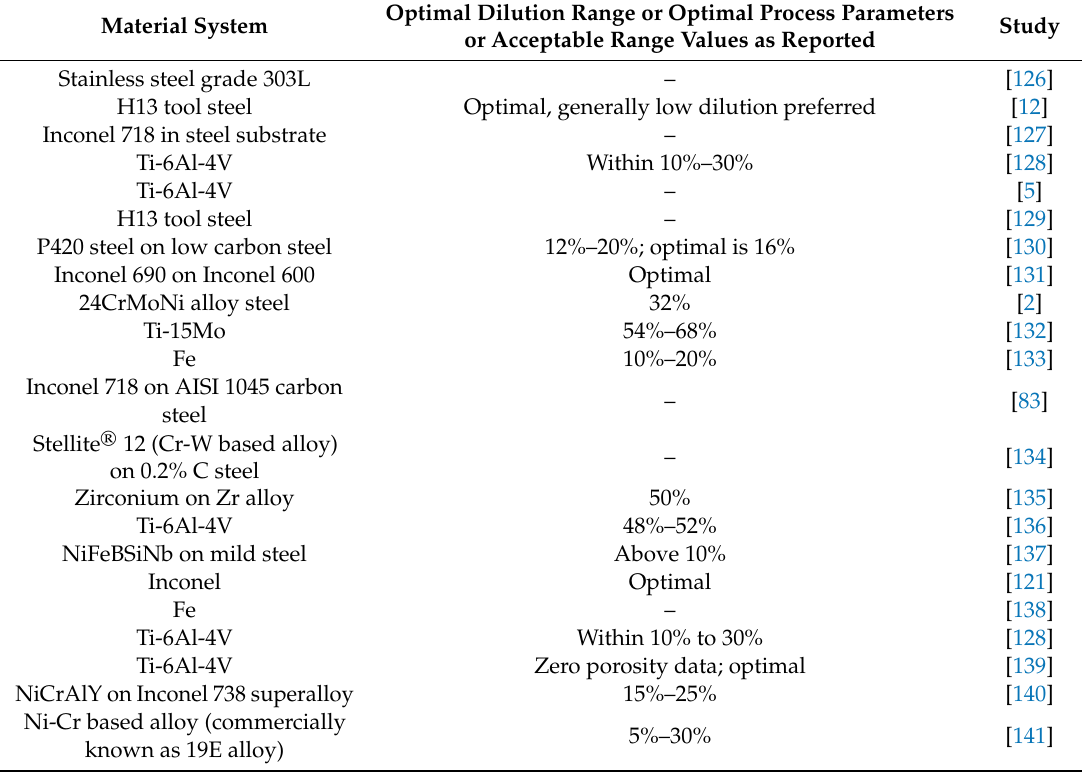
Table 5. Compilation of optimal processing data point ranges for DED deposited metal or alloy